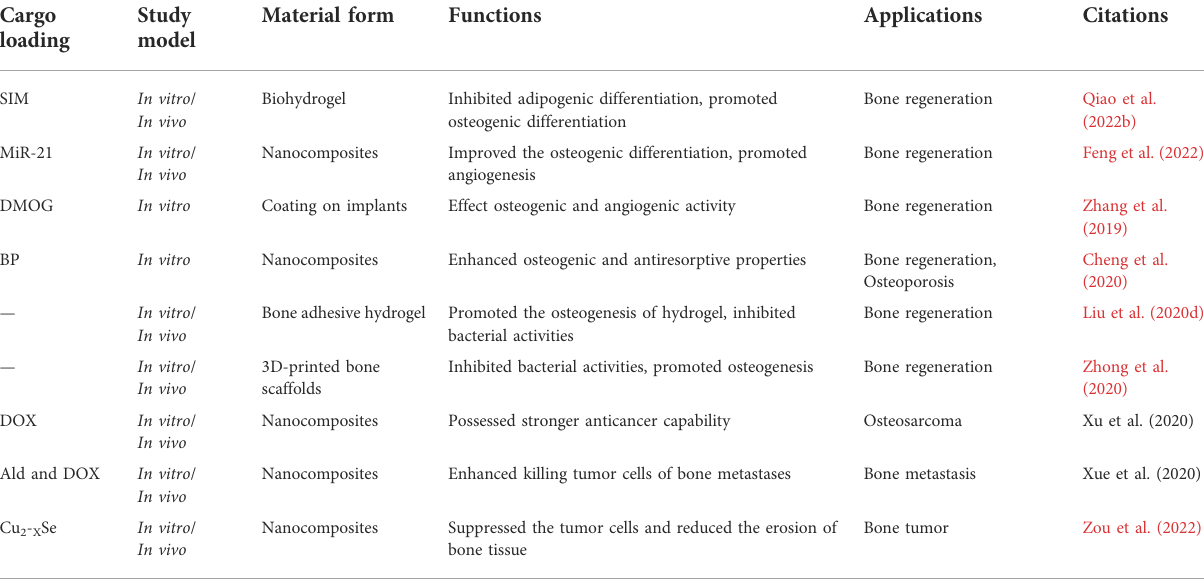
TABLE 2 Application of one Zn-based MOF (ZIF-8) in treating bone disease and regeneration. Cargo